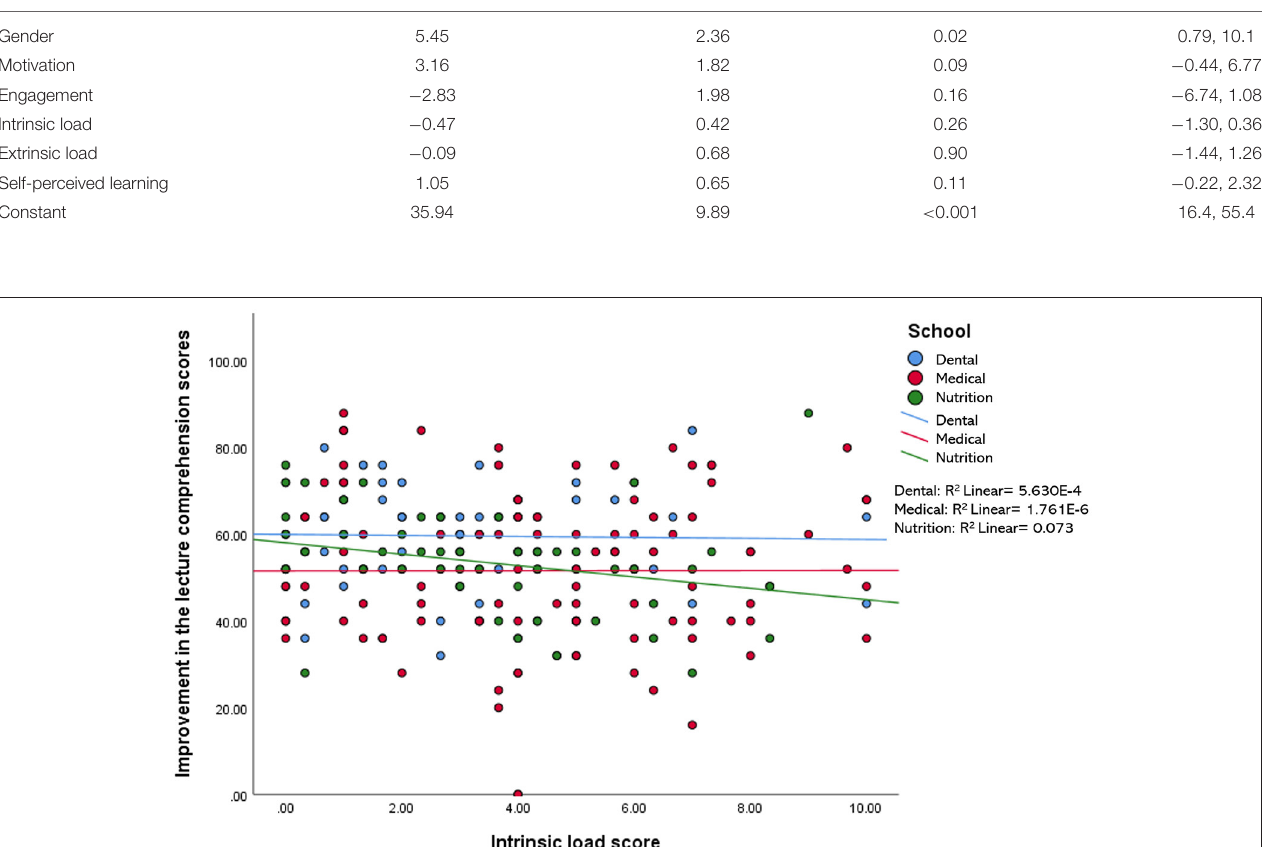
FIGURE 2 | Improvement of the lecture comprehension scores vs. the intrinsic load score after the CLT-based online